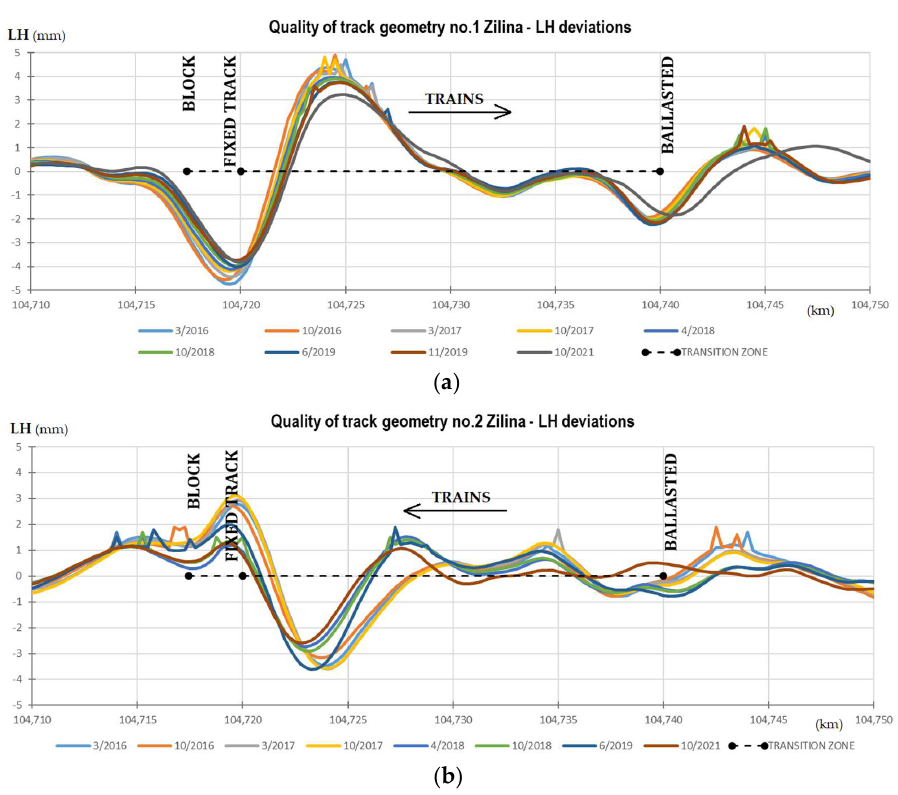
Figure 2. Inspection of track geometry quality—longitudinal height deviations (LH) of zones in Trencianske Bohuslavice from Figure 1b: ( a ) axis No. 1; ( b ) axis No. 2. Trencianske Bohuslavice from Figure 1b: ( a ) axis No. 1; ( b ) axis No.